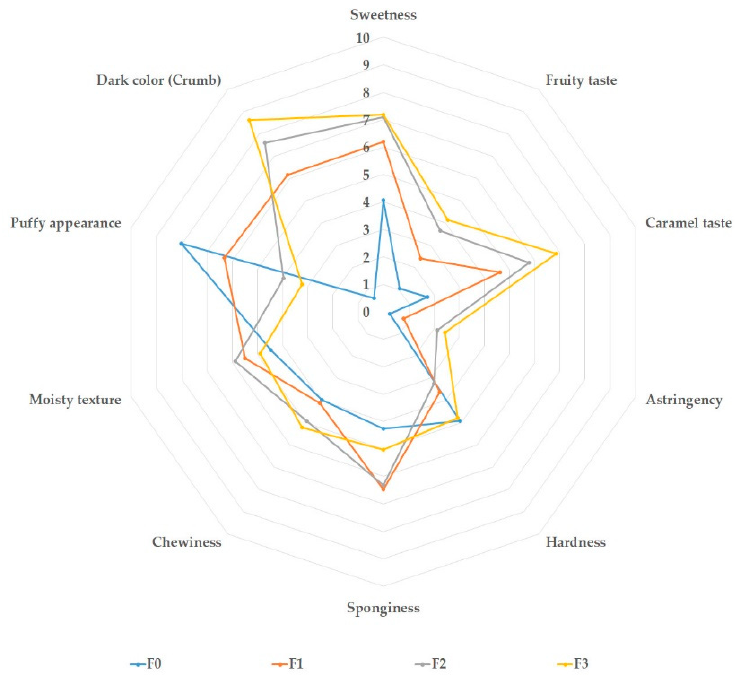
Figure 2. Mean QDA attributes scores performed by a trained panel ( n = 10). Minimum score = 0 and maximum score = 10. F0: muffins without persimmon flour (control sample). F1: 10% replacement of corn flour with persimmon flour. F2: 20% replacement of corn flour with persimmon flour. F3: 30% replacement of corn flour with persimmon flour.